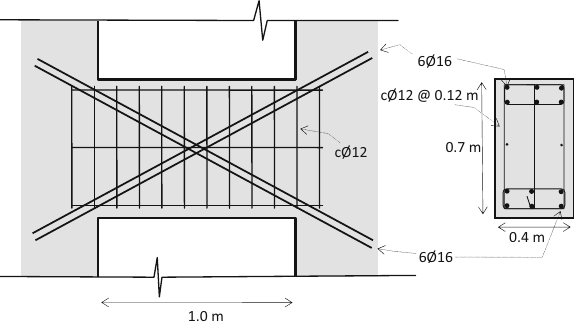
Fig. 16 Reinforcement of the coupling